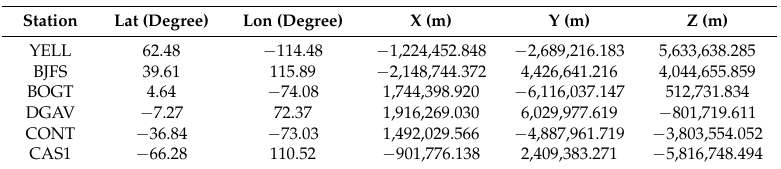
Table 4. Location and the IGS08 coordinates of the experimental data sets collected from 6 IGS stations at GPS Week 1773 for single-frequency standard point positioning.